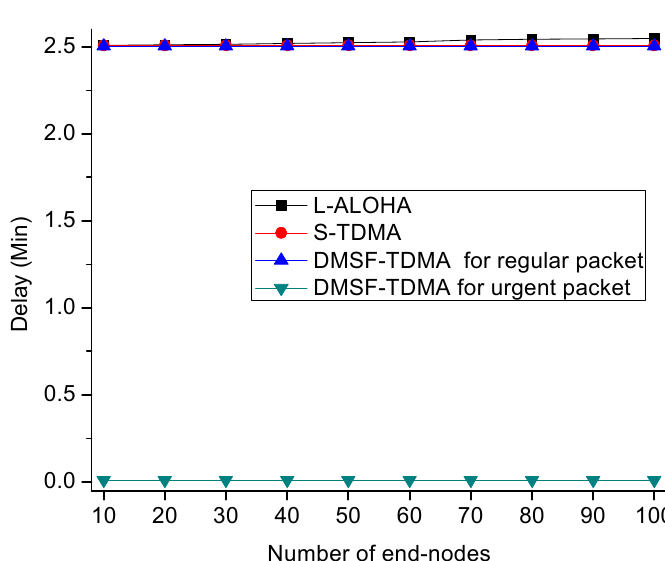
Figure 18. Average delay with a different number of end-nodes.